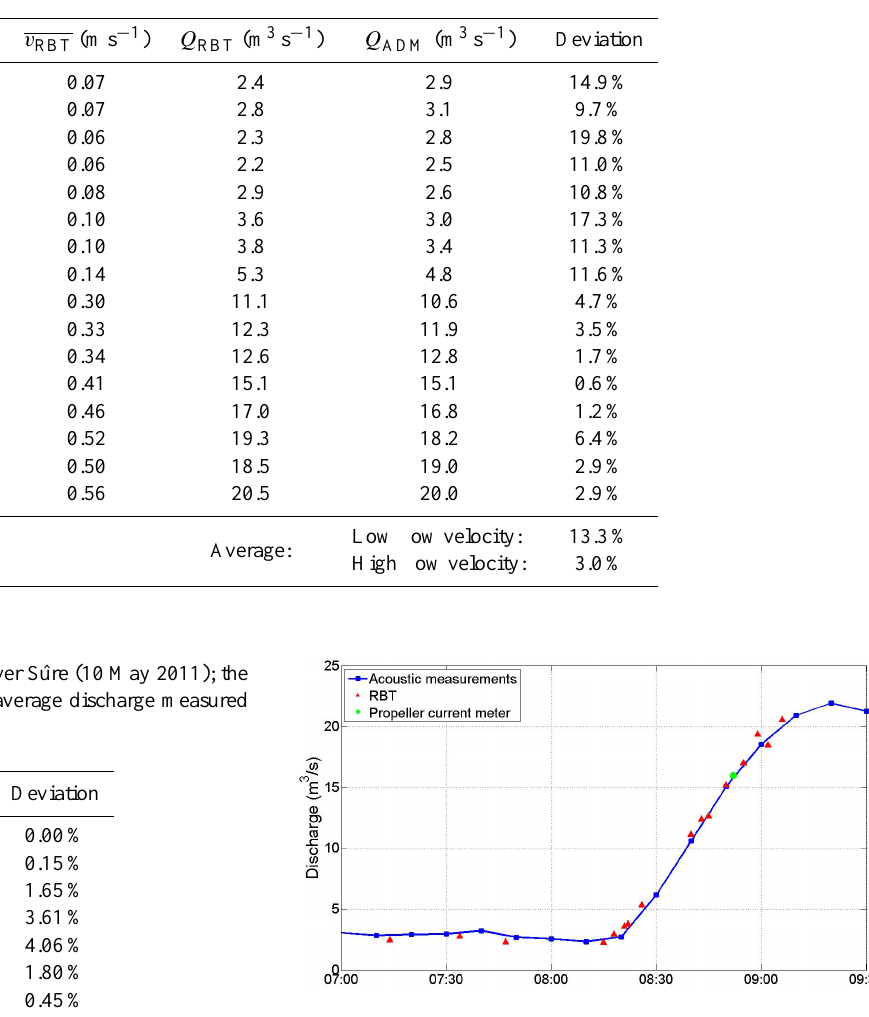
Table 2. Absolute percentage deviations for the discharges ( Q ) measured with the rising bubble technique (RBT) compared with the acoustic discharge measuring device (ADM) in Zoutkamp (9 October 2009); cross-sectionally averaged velocities v lower then 0.2ms − 1 are considered low.